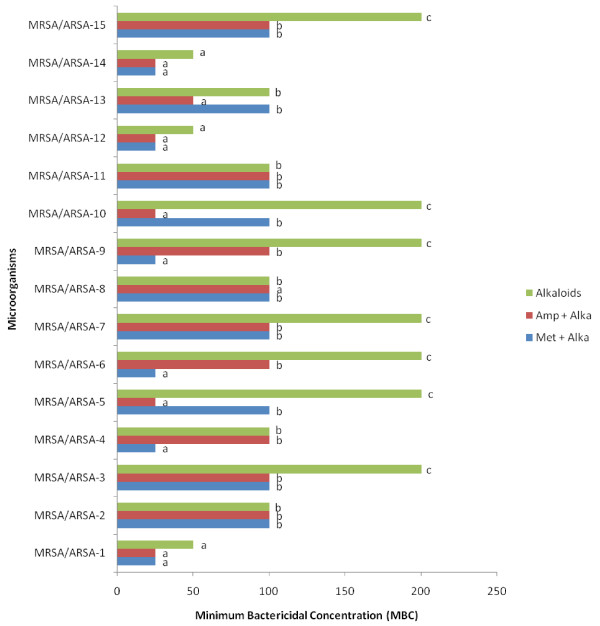
 Minimum bactericidal Concentration (MBC) of alkaloid compounds fromCienfuegosia digitataCav. and their combination with Methicillin and with Ampicillin. The results are the means of number of the colonies ± standard deviations.